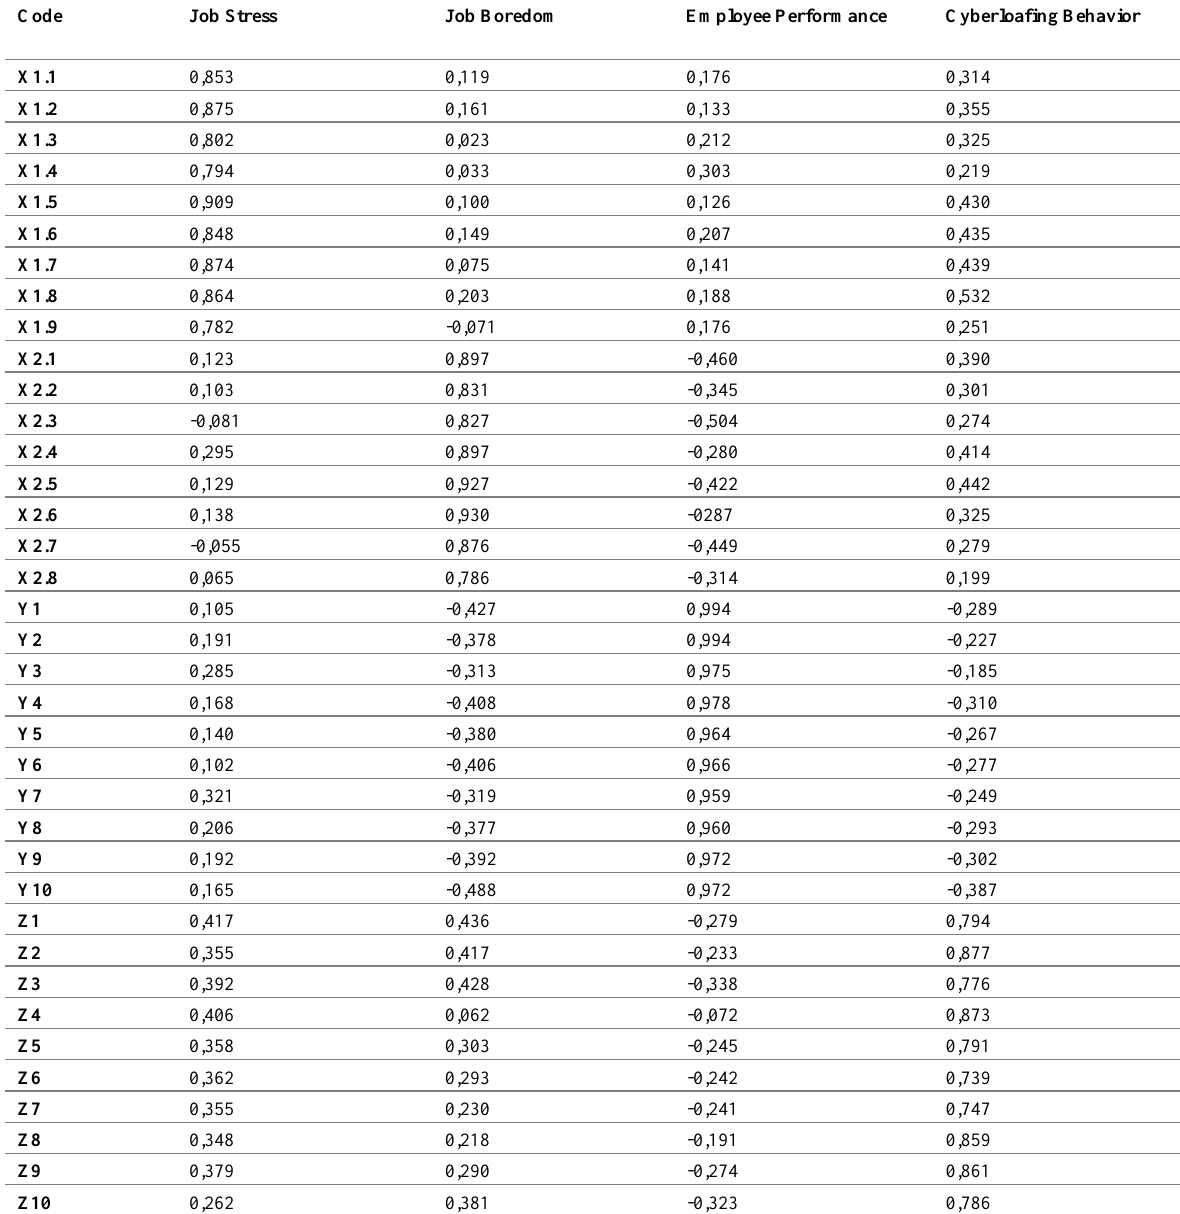
Table 3: Cross-Loading